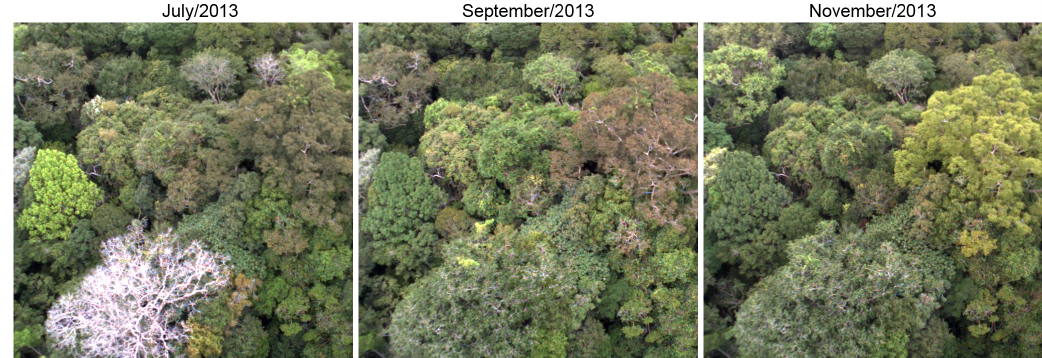
Figure 5. Portion of camera view, contrast enhanced. Spatial and temporal crown color differences are most evident in the five driest months (July to November) when crowns present rapidly changing phenostages associated with leaf flush, briefly deciduous pre-flush abscission, young red unexpanded leaves, or bright green recently expanded leaves.